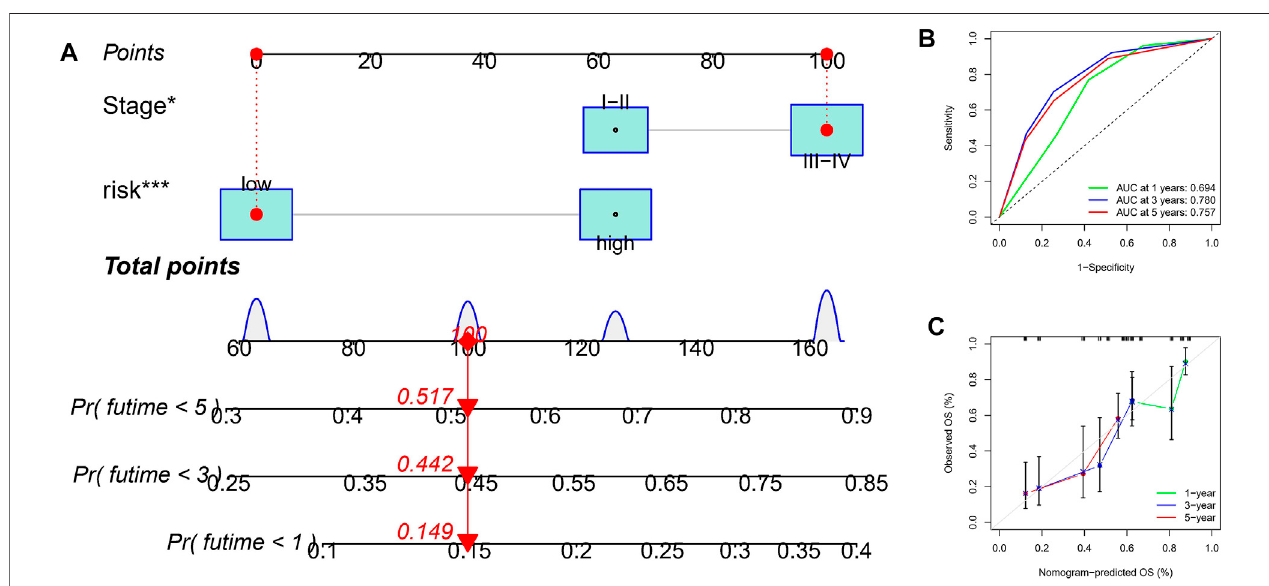
FIGURE6| Construction and veri fi cation ofnomogram. (A) A nomogram based on TNMstage and riskscore. (B) ROCcurvesofthe nomogram forOS prediction at 1, 3, and 5 years. (C) Calibration curves of nomogram for OS prediction at 1, 3, and 5 years.